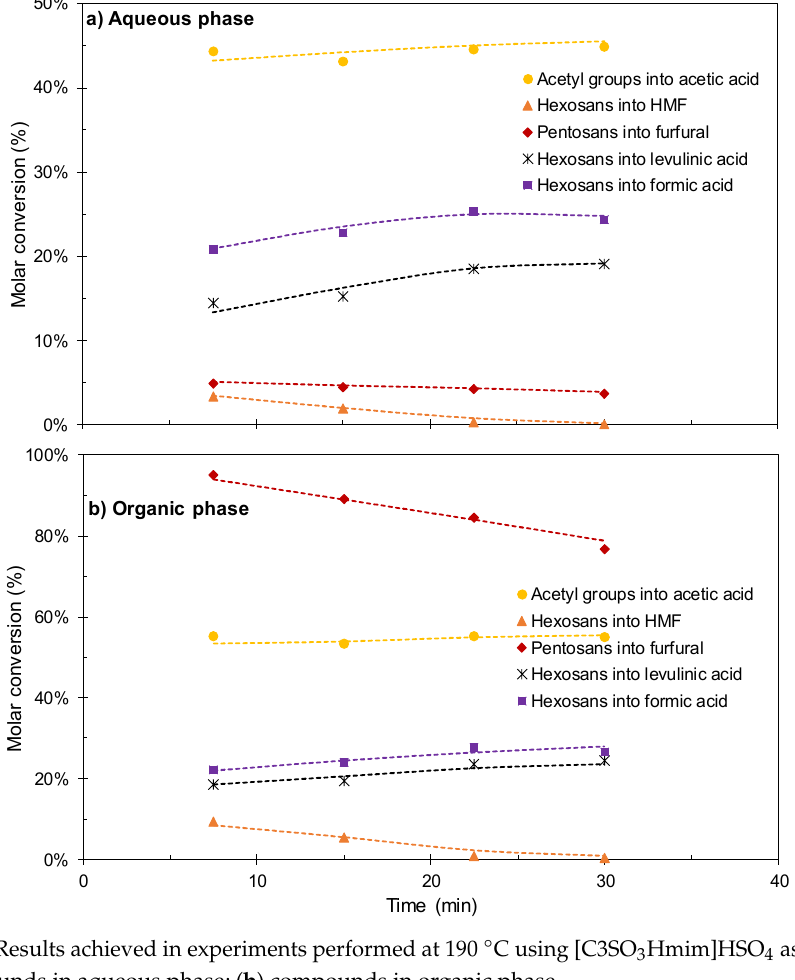
Figure 6. Results achieved in experiments performed at 190 °C using [C3SO 3 Hmim]HSO 4 as a catalyst. ( a ) compounds in aqueous phase; ( b ) compounds in organic phase.